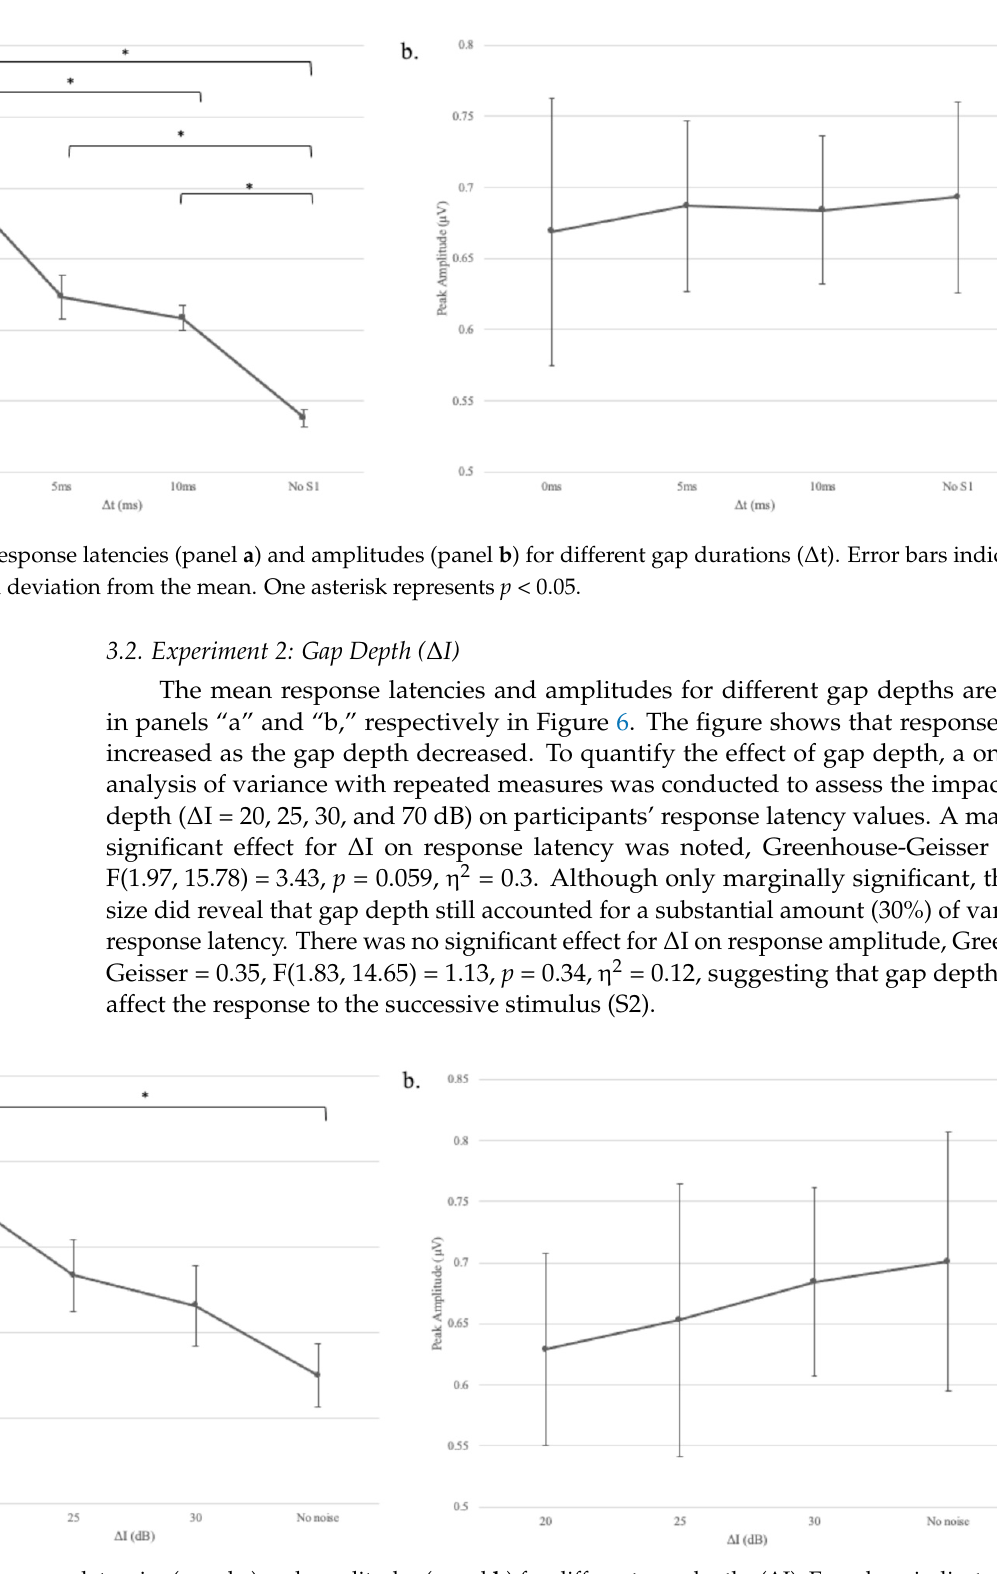
Figure 6. Mean response latencies (panel a ) and amplitudes (panel b ) for different gap depths ( ∆ I). Error bars indicate +/– one standard deviation from the mean. One asterisk represents p < 0.05. The no-noise condition refers to ∆ I = 70 dB and the continuous noise was absent.